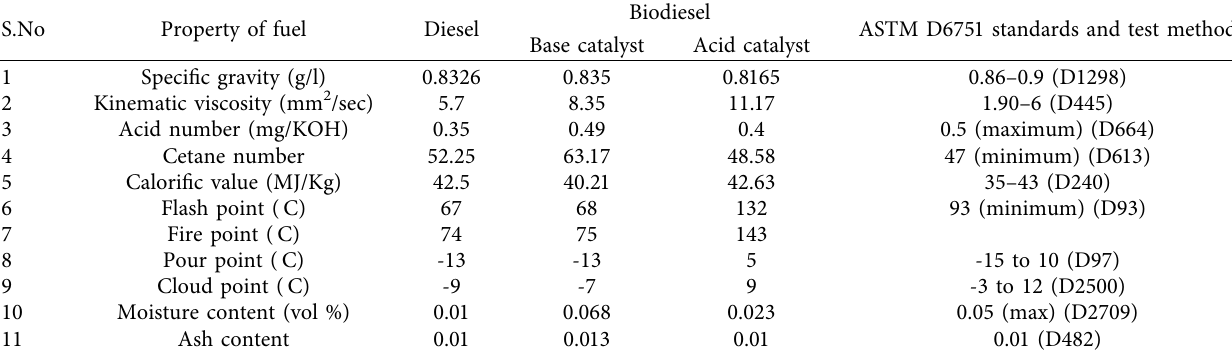
Table 2: Comparison of the physiochemical properties of biodiesel with ASTM